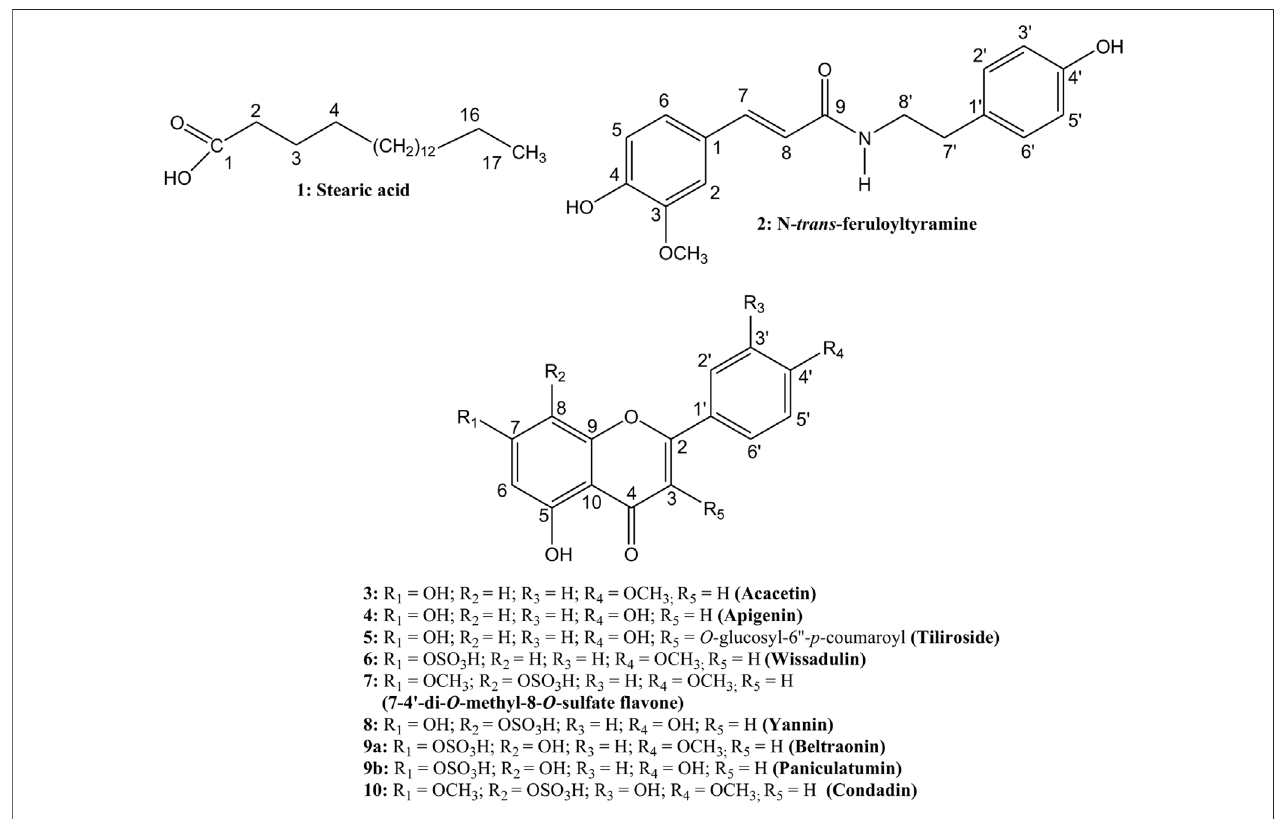
FIGURE 1 | Compounds isolated from Sidastrum paniculatum (L.) Fryxell.